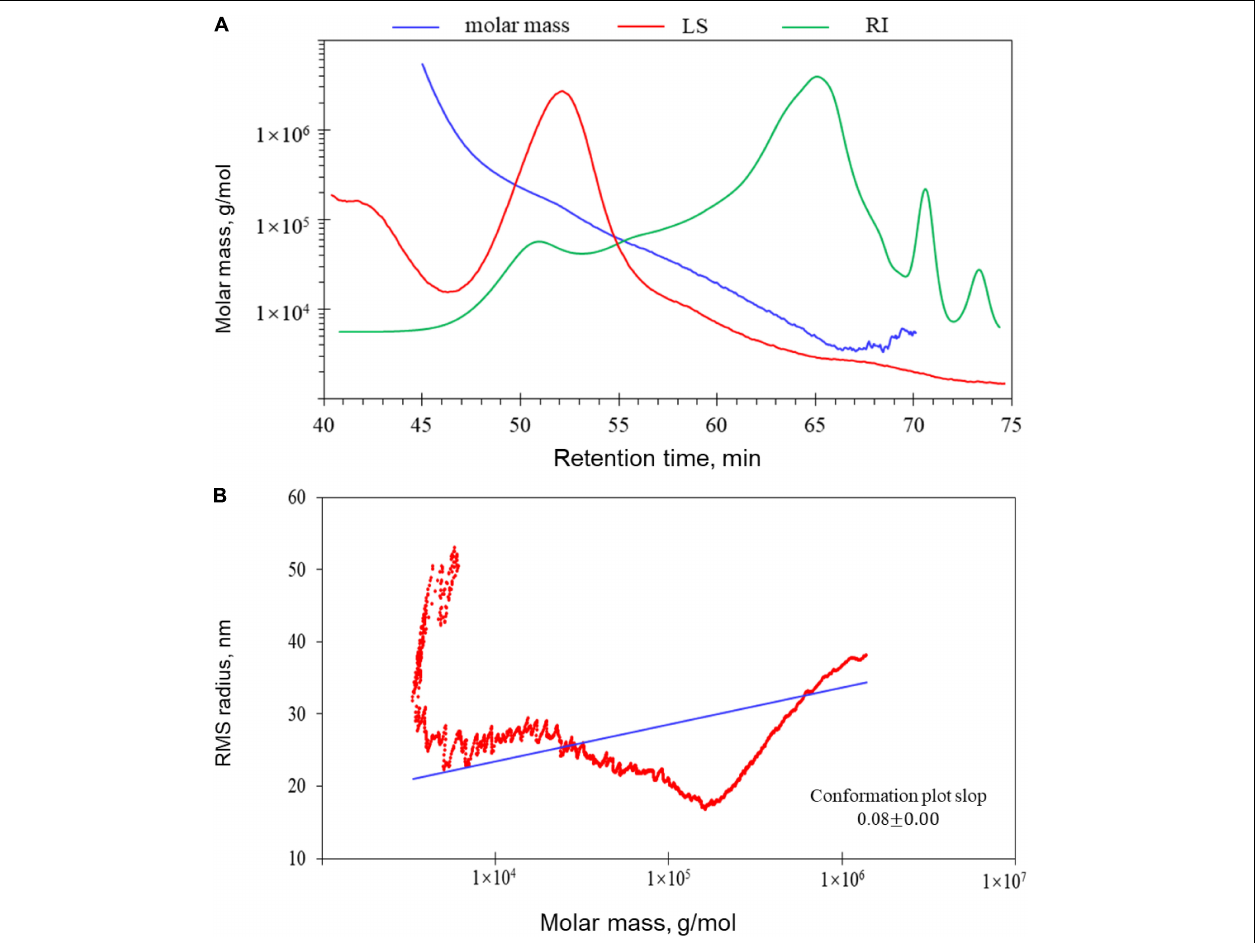
FIGURE 4 | Gel permeation chromatography-refractive index-multiangle laser light scattering (GPC-RI-MALS) chromatograph with molecular weight distribution (A) and molecular conformation of LJPS (B) . (A) The variation tendencies of signals of the multi-angle laser scattering (LS), refractive index (RI), and fitted molar mass of LJPS. The red line indicates the variation tendency in the LS of LJPS with retention time, and the green line represents the trend in the RI of LJPS. The tendency of the red and green lines suggested the size of the PS molecules and their relative proportions contained in the tested sample. The blue line is the varying tendency of the molar mass fitted by the LS and RI signal of the PSs following the retention time. (B) Molecular conformation speculation plot, taking the log (molar mass) as the horizontal coordinate and log (RMS) as the vertical